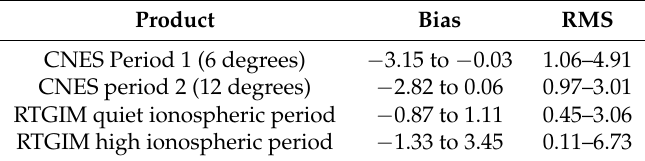
Table 4. Accuracy of the CNES VTEC and RTGIM compared with the reference (unit: